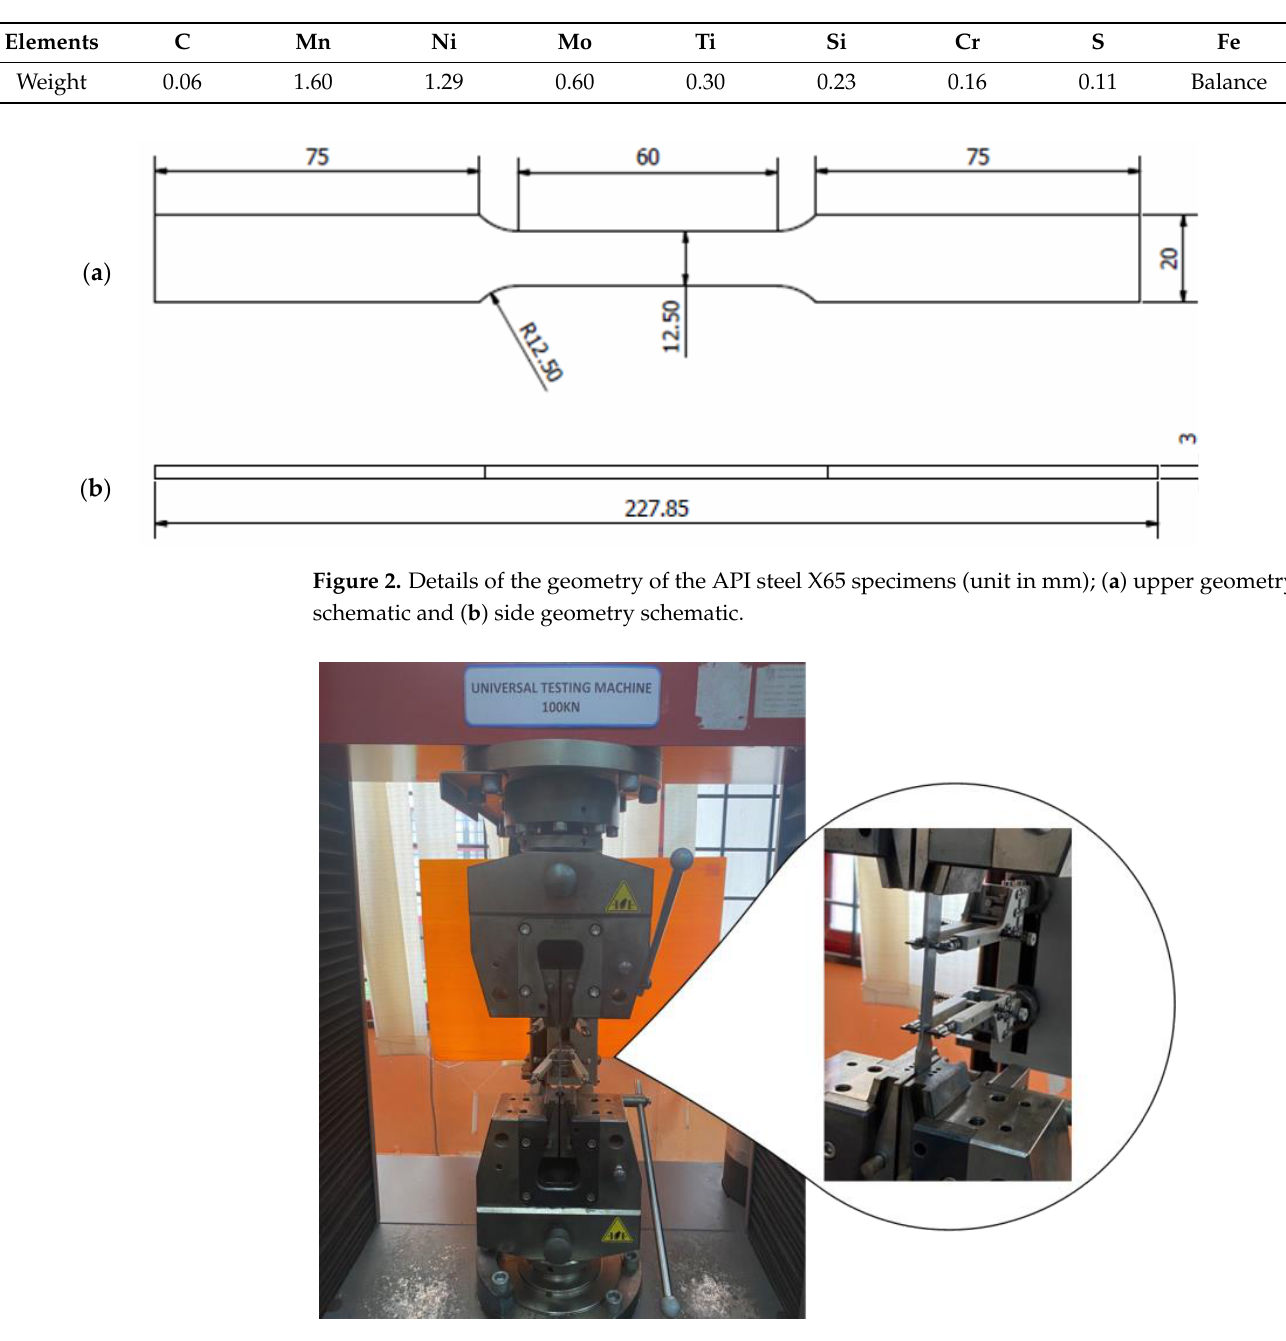
Figure 3. Specimen set-up for tensile test.